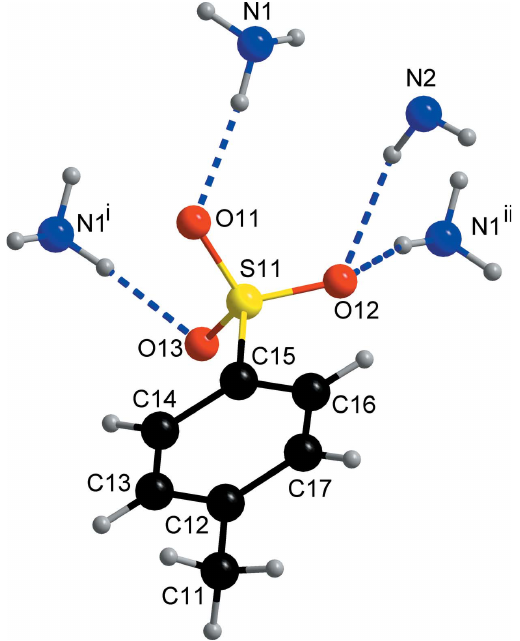
Figure 3 A view down [010] of the packing in 1 with N—H (cid:2)(cid:2)(cid:2) O hydrogen bonds shown as dashed lines.